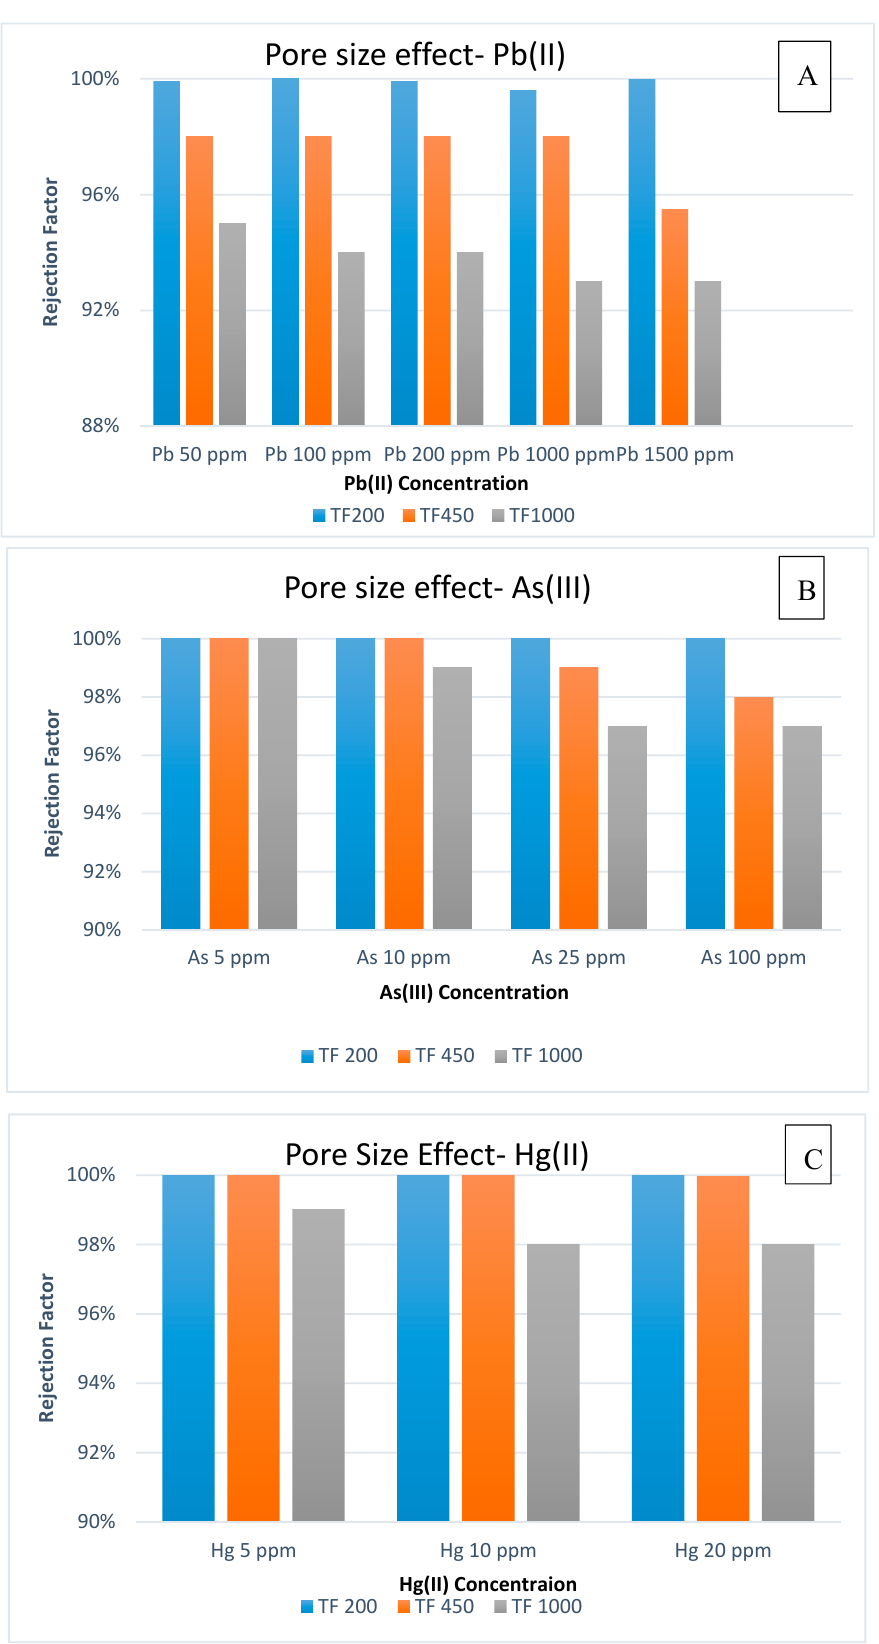
Figure 2. Pore size effect for different heavy metals using TF200, TF450 and TF1000: ( A ) Pb(II), ( B ) As(III), and ( C ) Hg(II).